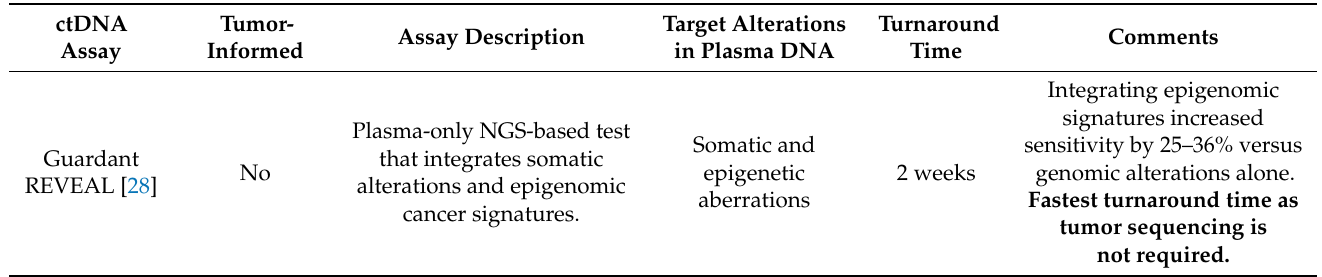
Table 1. ctDNA assay platforms utilized to assess minimal residual disease (MRD) in major prospec- tive studies in